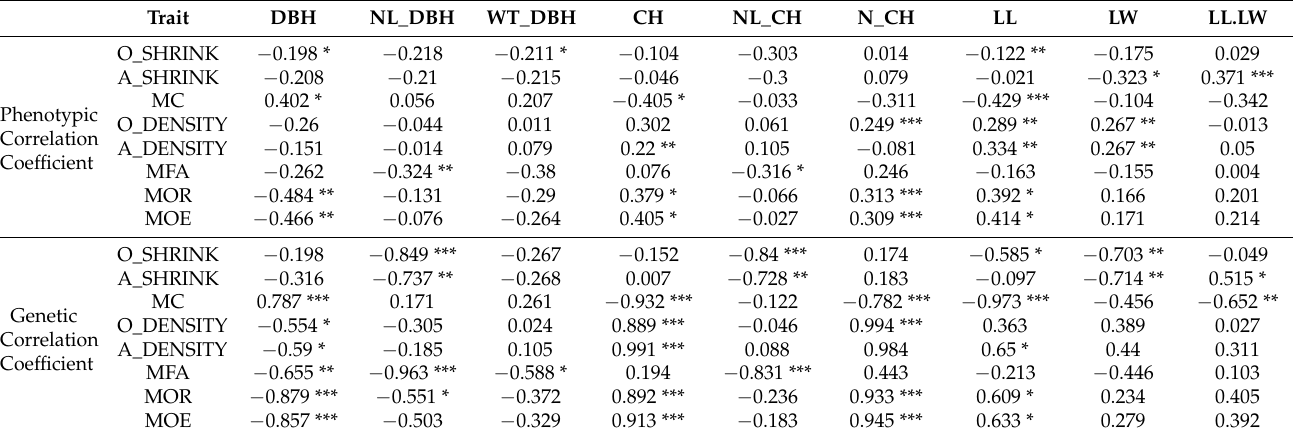
Table 3. Correlation analysis between phenotypic traits and material properties in Moso bamboo ( Phyllostachys edulis